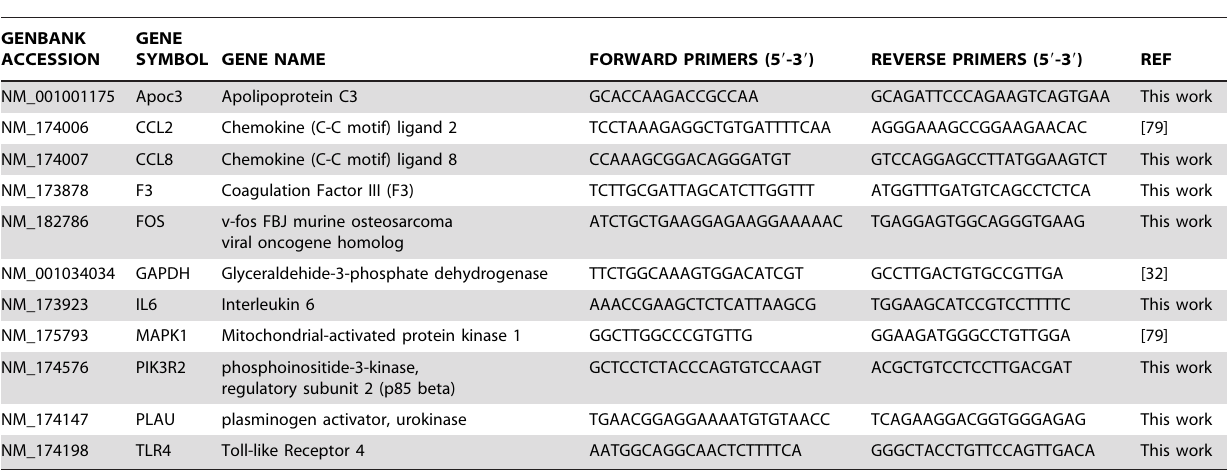
Table 1. Primer sequences for real time PCR validation of microarray